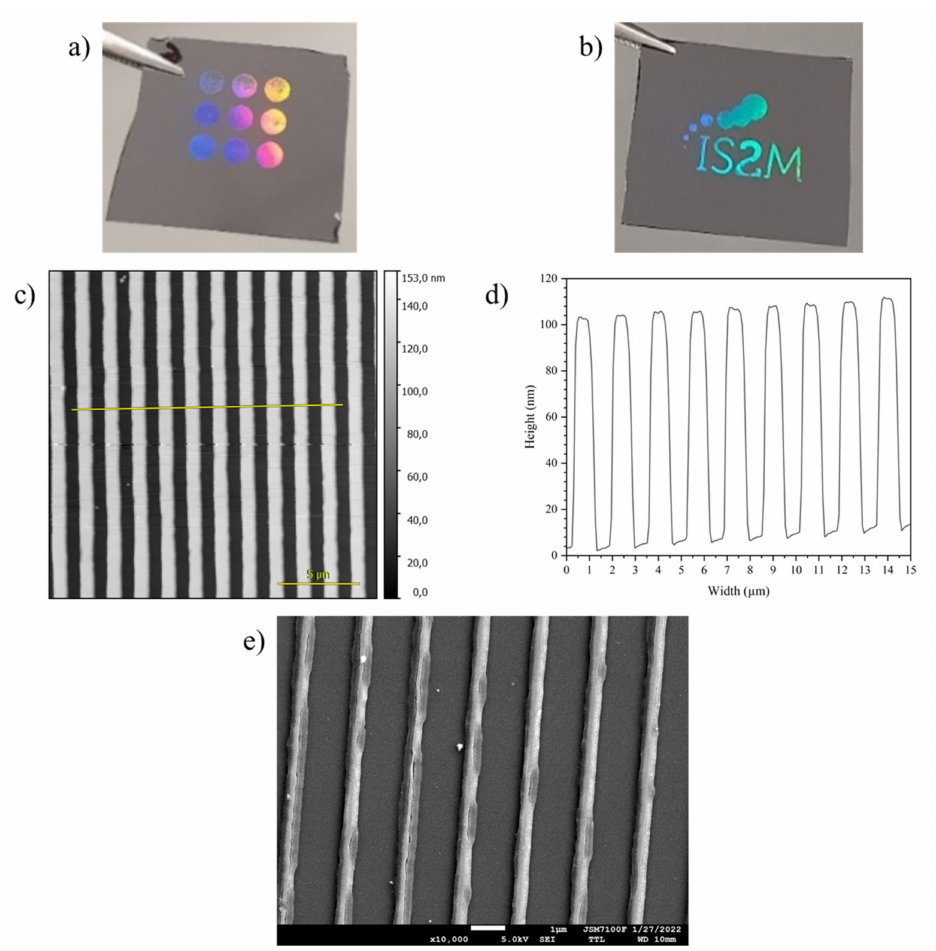
Figure 4. HfO 2-DUV thin films patterned by deep UV lithography. ( a ) Photograph of a film with a periodic pattern (1.6 µ m period). The circles were printed with doses ranging from 100 to 300 mJ/cm 2 (in steps of 25 mJ/cm 2 ). ( b ) Photograph of a periodic pattern (1.6 µ m period) written through a mask to draw the IS2M logo (200 mJ/cm 2 ). ( c ) Atomic force microscopy image of the 1.6 µ m period patterns (200 mJ/cm 2 ) and ( d ) cross-section corresponding to the red segment in part c. ( e ) SEM image of the patterned sample after thermal annealing at 600 ◦ C for 1